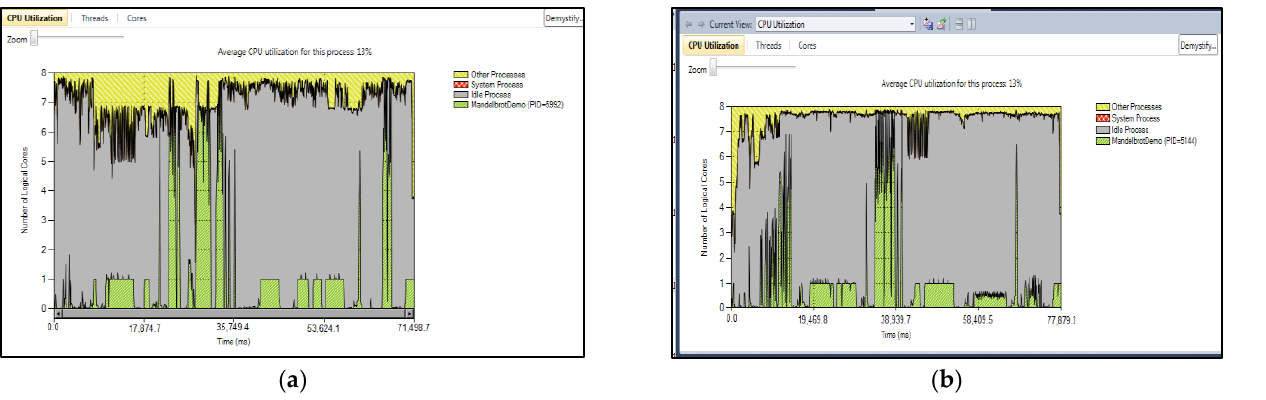
Figure 14. Scenarios for CPU usage during the application: ( a ) The description over 71 s with a variety of changes in the sequential work context vs. parallel; ( b ) the description for 78 s with a variety of changes in the sequential work context vs. parallel cases scenarios.